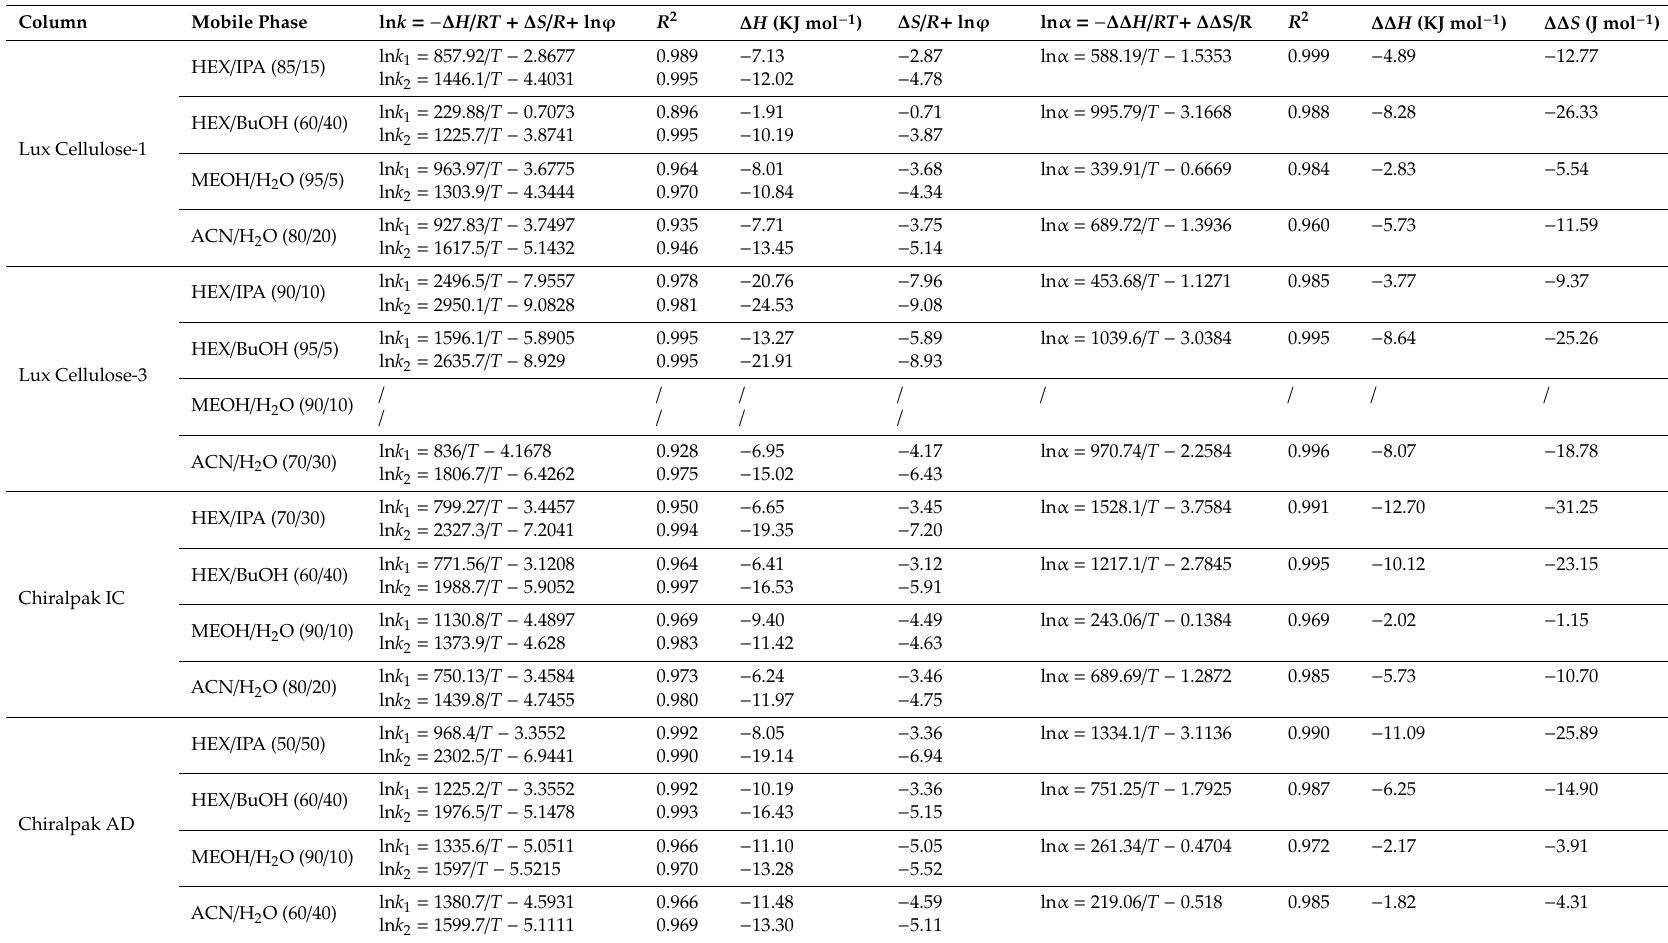
Table 2. Van’t Ho ff equations and thermodynamic parameters of etoxazole enantiomers with four chiral